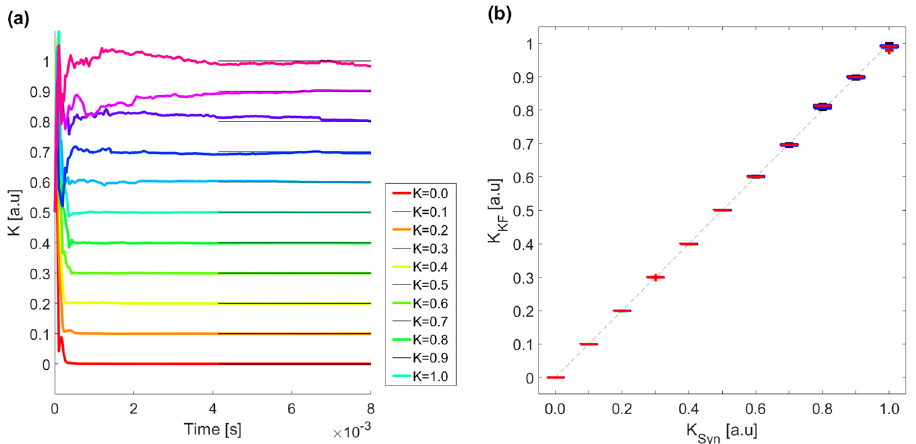
Figure 6. ( a ) UKF estimations obtained from the observations y i ( i = 1, . . . , 28 ) for K parameters ranging from 0 to 1. The network of N = 28 nodes corresponds to the Network 1 as presented in Ref. 41 and parameters shown in Table 1. In this case, the observation noise is smaller (which makes a faster convergence of the estimations) and the duration of the time traces is shorter than in Fig. 3. The solid black lines indicate the values of the K parameters to be estimated during the filtering. ( b ) Comparison of the estimated and synthetic K using boxplots. For each boxplot, the red line is the median, the upper and lower whiskers of the bars represent the maximum and minimum limits, and the red points refer to outliers. In these simulations, we have used fully stabilized parameters so they show almost perfect estimated values.